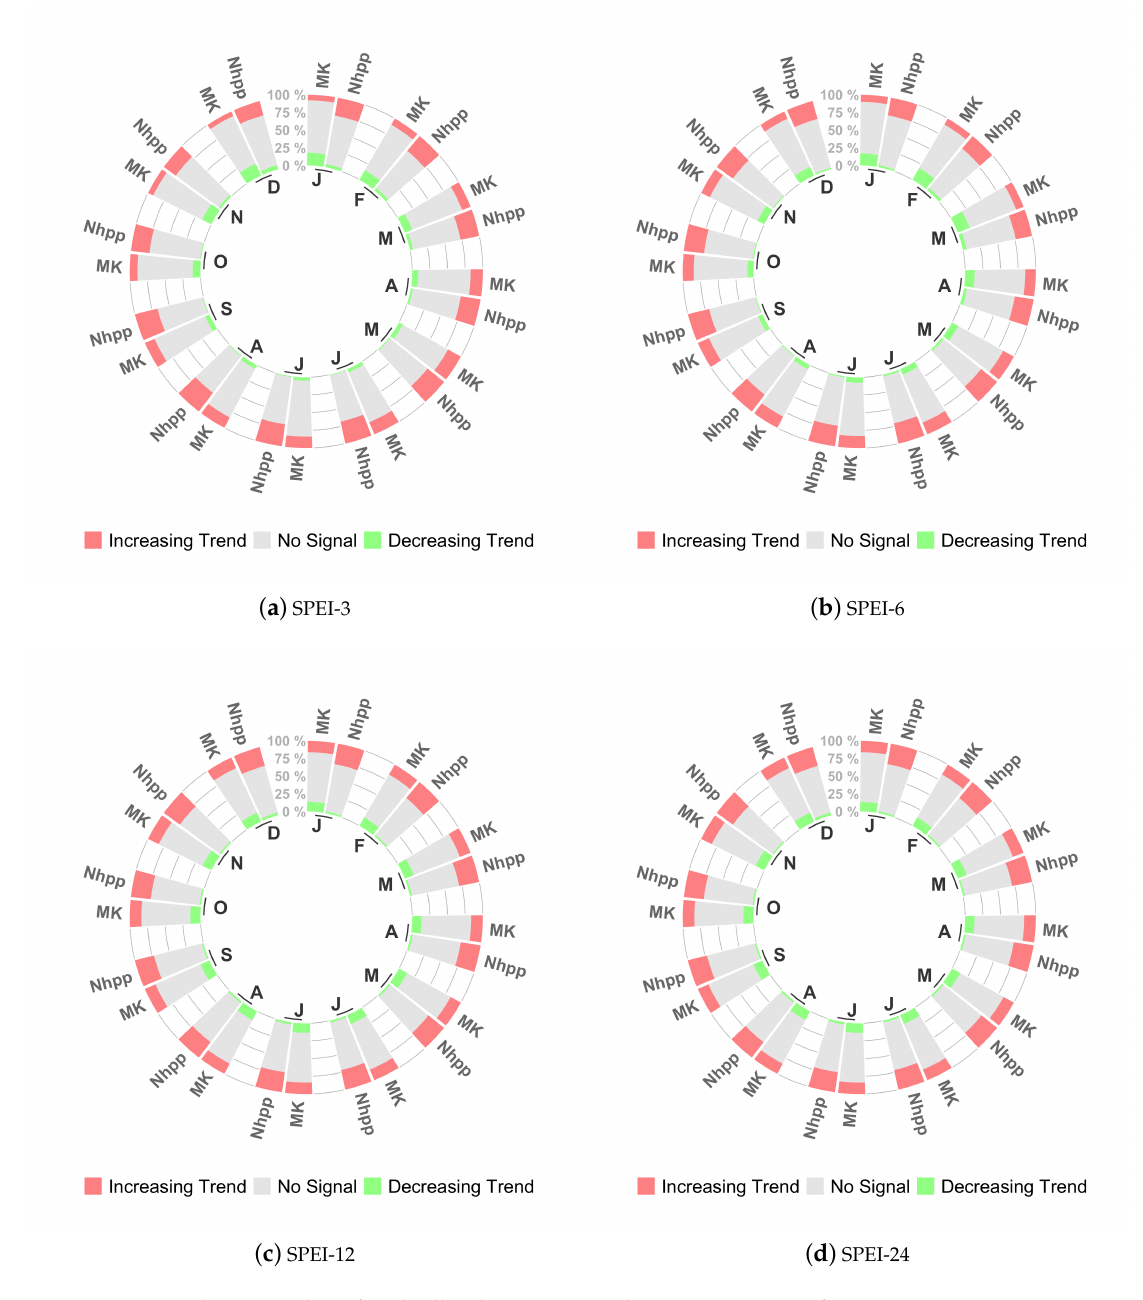
Figure 4. Relative number of grid cells where NHPP and M-K test give significant (positive or negative) and non-significant trend for each month in the period 1901–2018: ( a ) SPEI-3; ( b ) SPEI-6; ( c ) SPEI-12; and ( d ) SPEI-24. Table 3. Variation in the percentage of NHPP positive trend cases to M-K positive trend, for each month and SPEI-time